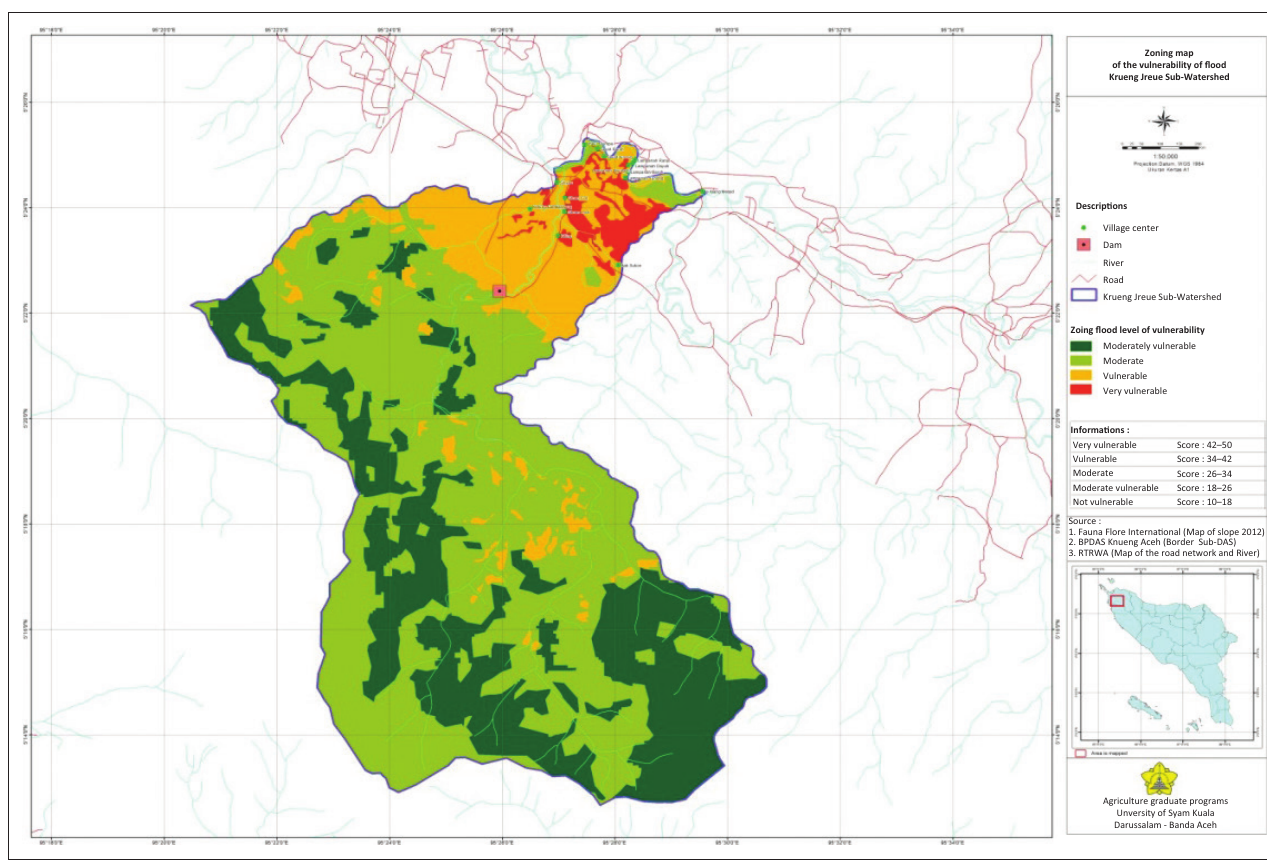
FIG URE 1: Zoning map of the vulnerability of flood in the Krueng Jreue Sub-Watershed. TABLE 8: Main and additional components of hydrological disaster vulnerability parameters. No.